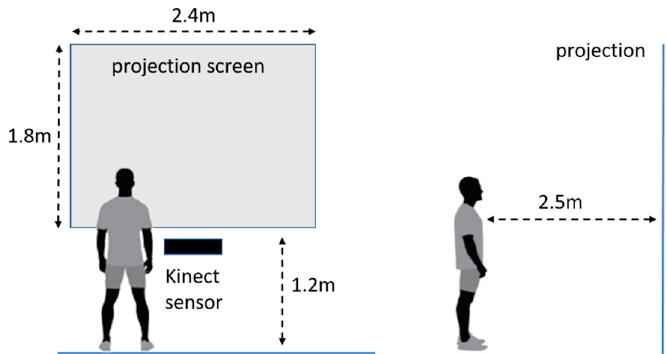
Figure 2. Setup of the experiment. Left: projection screen dimensions and placement and sensor placement. Right: distance between the user and projection screen.